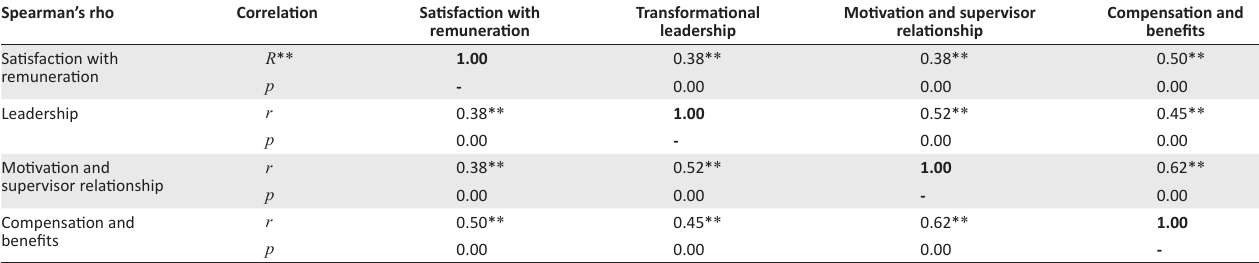
TABLE 4: Correlations between all four sub-factors. Spearman’s